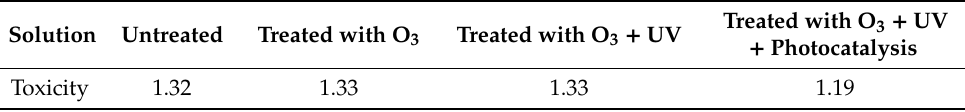
Table 4. Toxicity of a solution of the 15 pharmaceutical products concentrated at 50 µ g / L after the di ff erent treatment